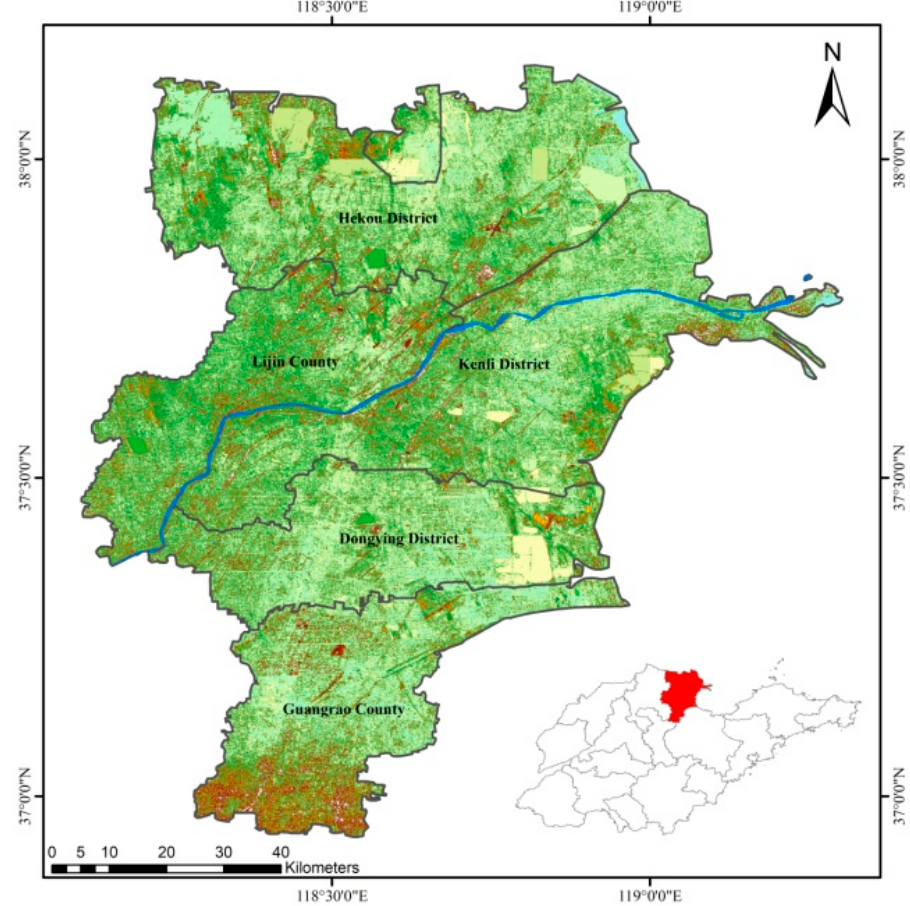
Figure 1. Overview of the study